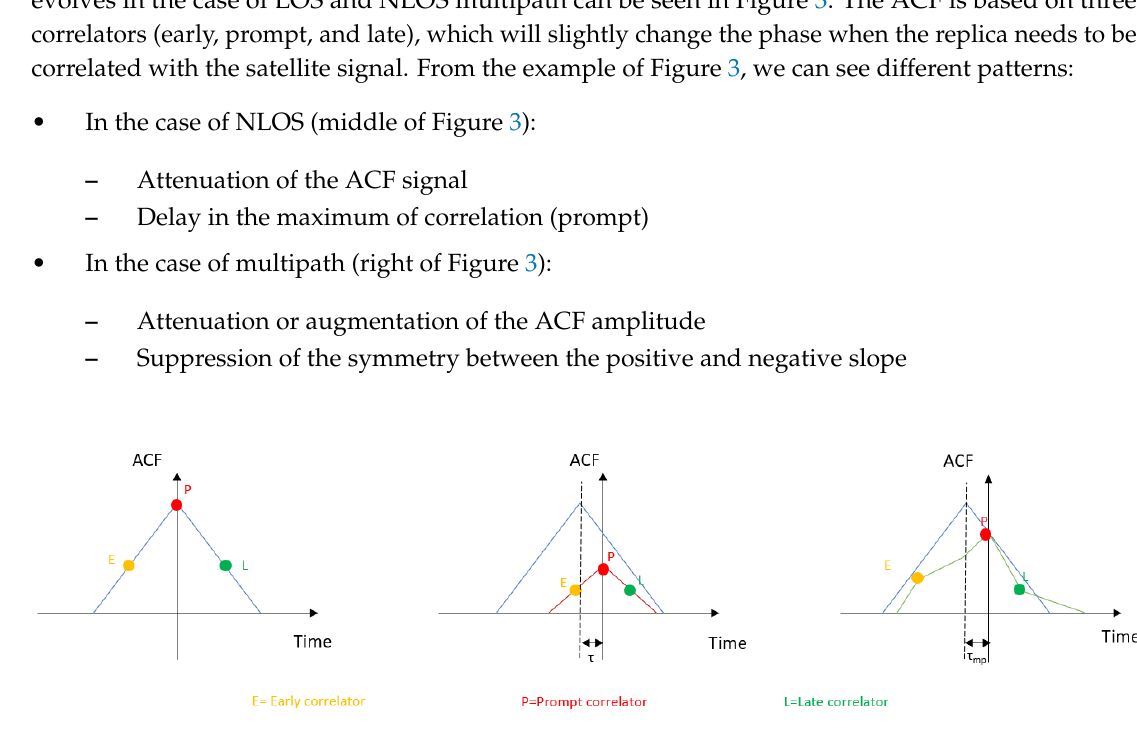
Figure 3. Different shapes of the ACF in LOS ( left ), NLOS ( middle ), and multipath situations ( right ). López-Salcedo et al. [8] proposed to use this slope asymmetry to detect multipath. They